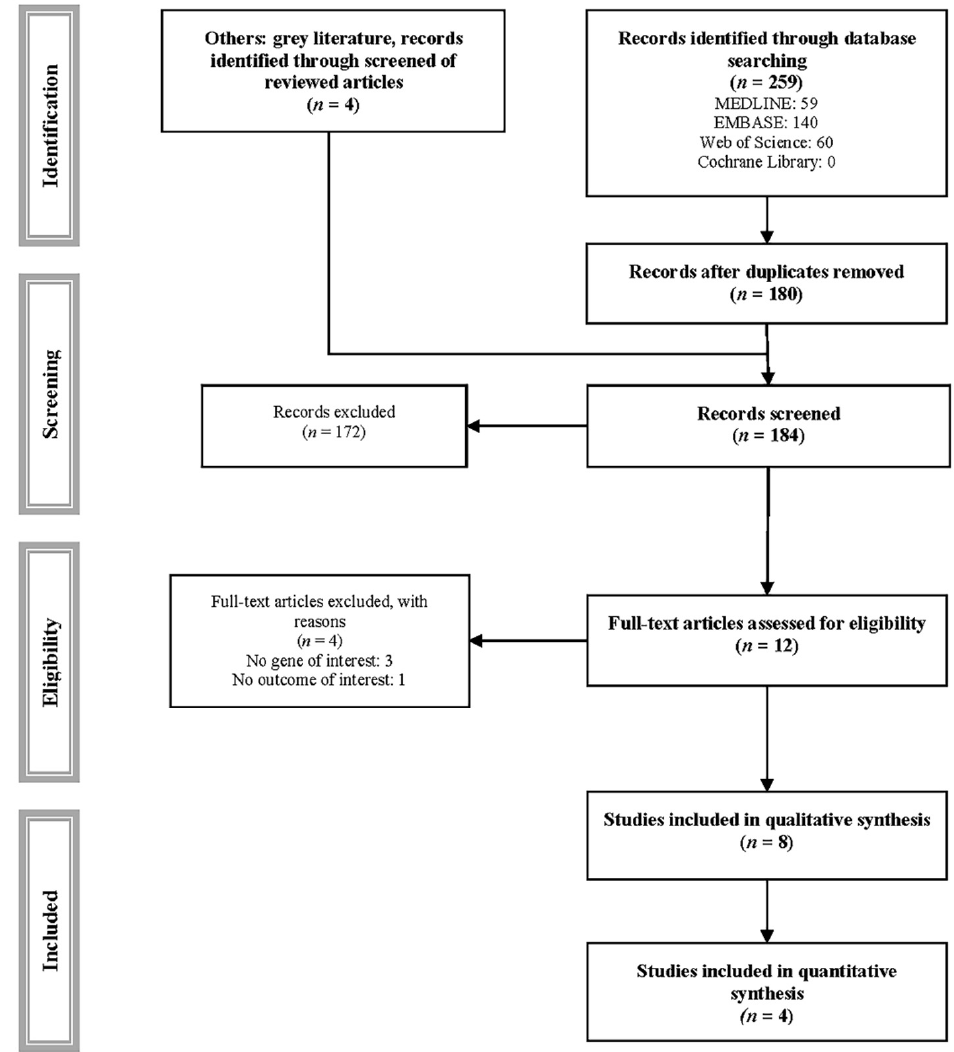
Figure 1. PRISMA flowchart of study selection. Table 1. Characteristics of the included studies.